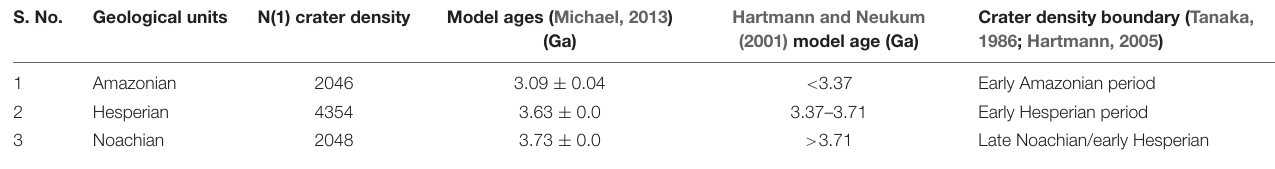
FIGURE 7 | Chronology model of Mars, modified after (Hartmann and Neukum, 2001) with indicated Martian eras. The study area crater counting model ages of the Amazonian unit, Hesperian unit, and Noachian unit, respectively. The N(1) crater density of 2046 craters in the Amazonian unit corresponds to the early Amazonian period, whereas 4354 craters in the Hesperian unit correspond to early Hesperian and 2048 craters to the late Noachian/early Hesperian in the Noachian geologic unit according to the established crater density boundaries. TABLE 1 | The chronological derived age comparison of the Amazonian, Hesperian, and Noachian units with the (Michael, 2013) model ages. S.